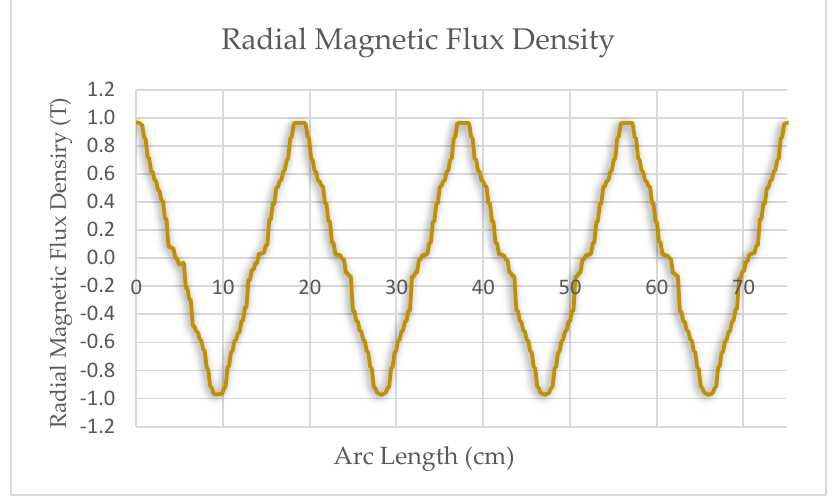
Figure 9. Radial magnetic flux density waveform at center of air gap. The radial magnetic flux waveform shows a very mild distortion at the region of slots opening. The open-circuit voltage of the generator has been evaluated to analyze the waveform for the generator emf. Figure 10 shows the open circuit AC voltage of the generator.